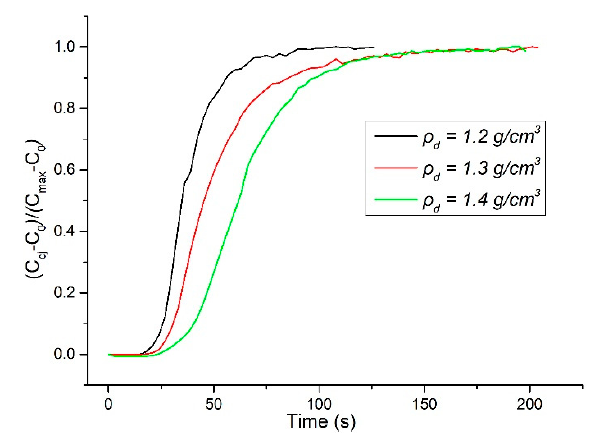
Figure 9. One-dimensional dispersion curves of coral sands with different dry densities.